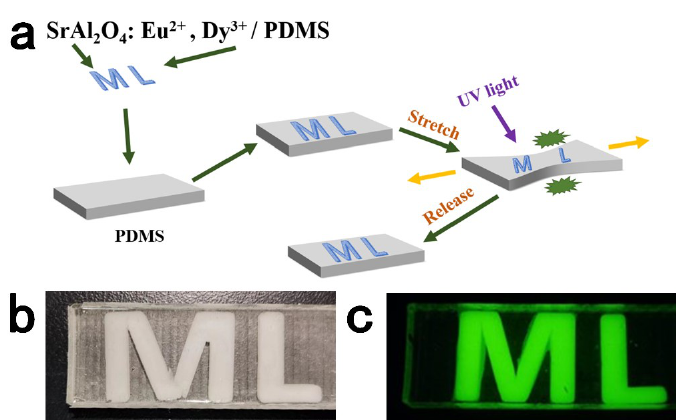
Figure 15. ( a ) Preparation process of PDMS composites and its elastic properties, ( b ) PDMS compos- ites in natural light, ( c ) PDMS composite under UV lamp